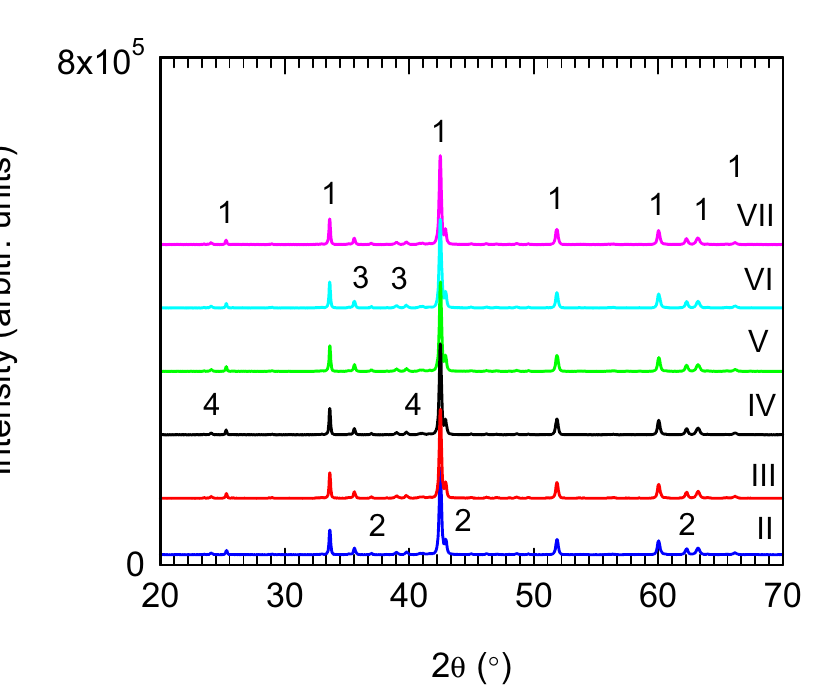
Figure 3. XRD patterns of samples “II–VII” (Table 1). Phases are 1-MgB 2 (ICDD 72-7019), 2-MgO (ICDD 35-0821),